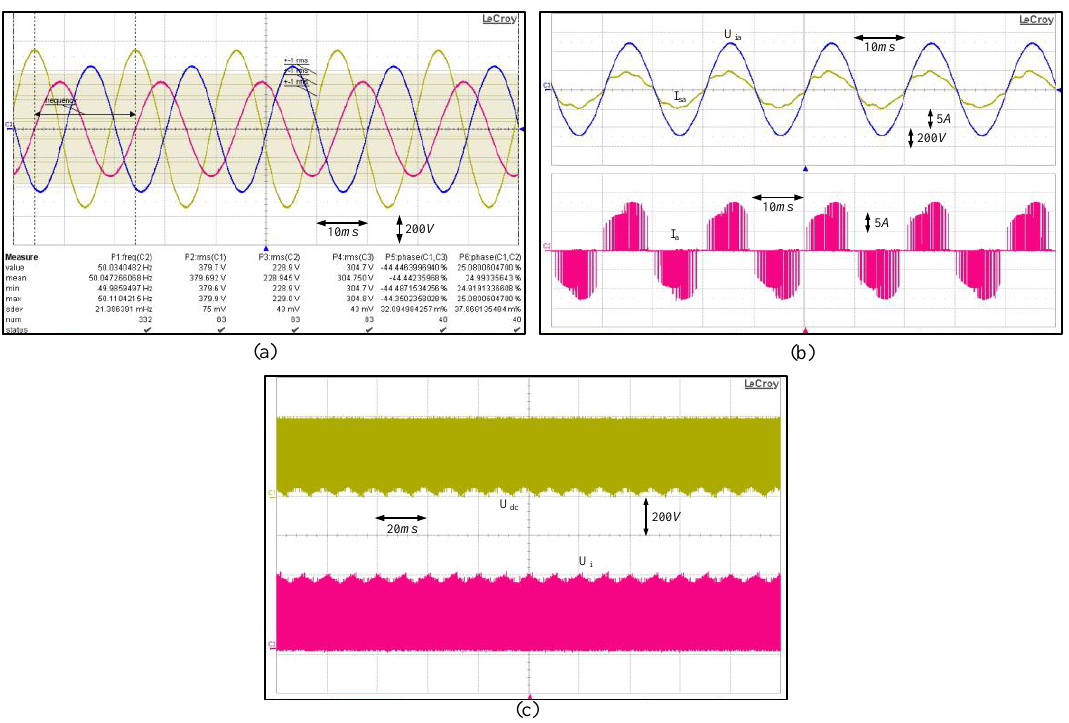
Figure 18. Steady-state performance ( a ) three phase abnormal input voltage; ( b ) input current after